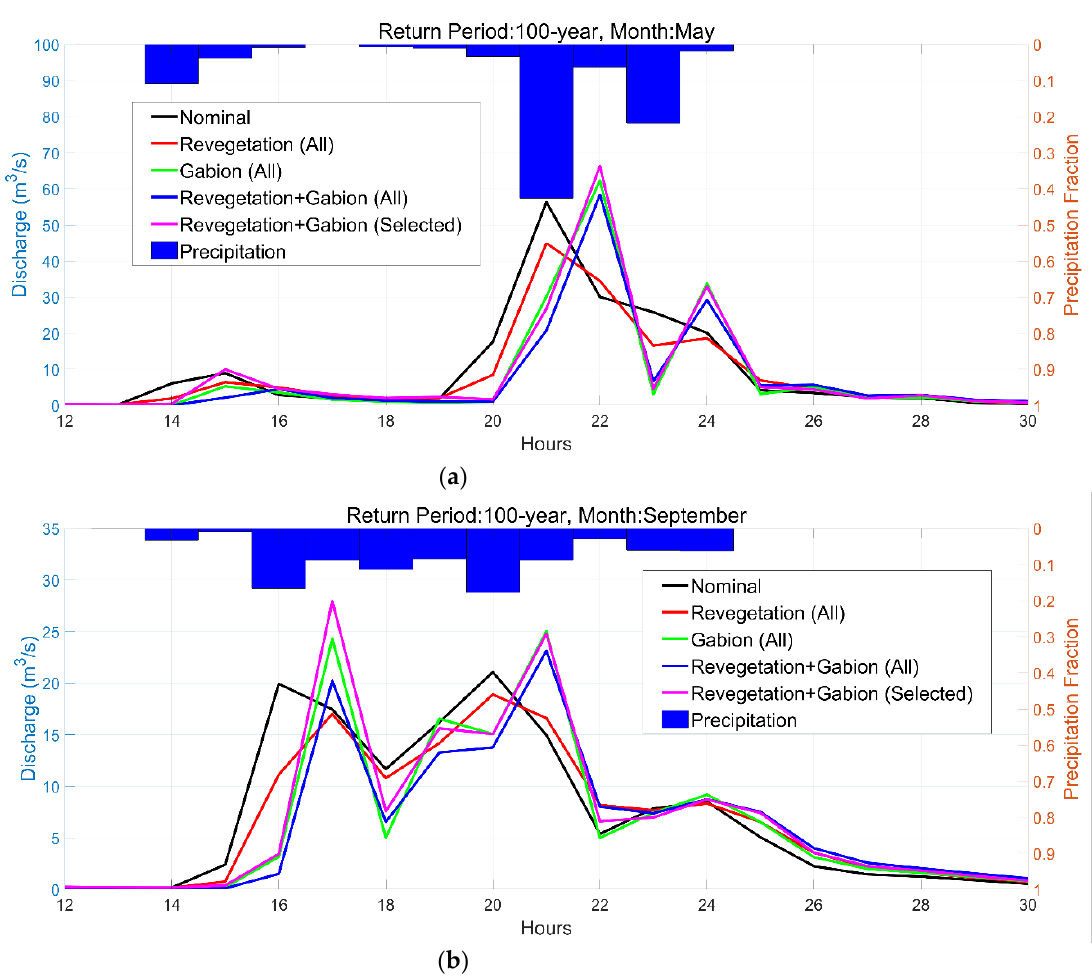
Figure 12. Comparison of flow hydrograph at the outlet of the study area for different mitigation plans with the nominal case for 100-year design storm in: ( a ) May and ( b ) September.